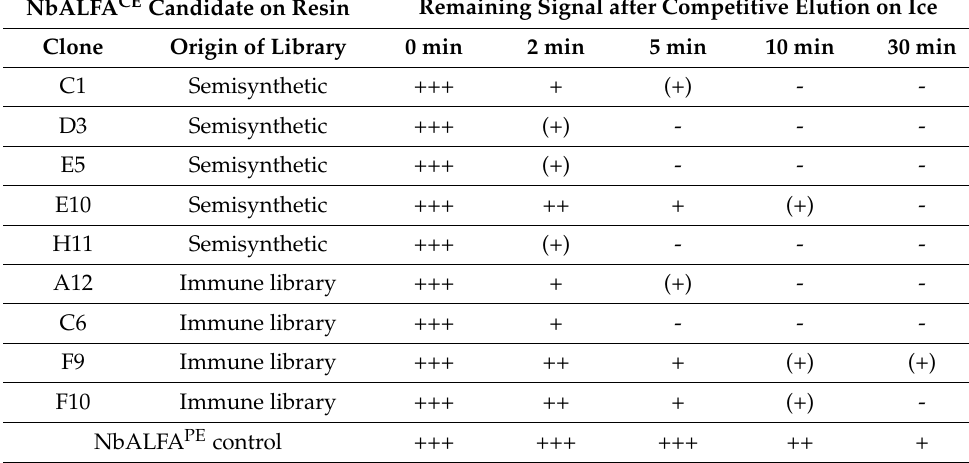
Table 1. Binding properties of selected ALFA binders obtained from an immune library and a semisynthetic